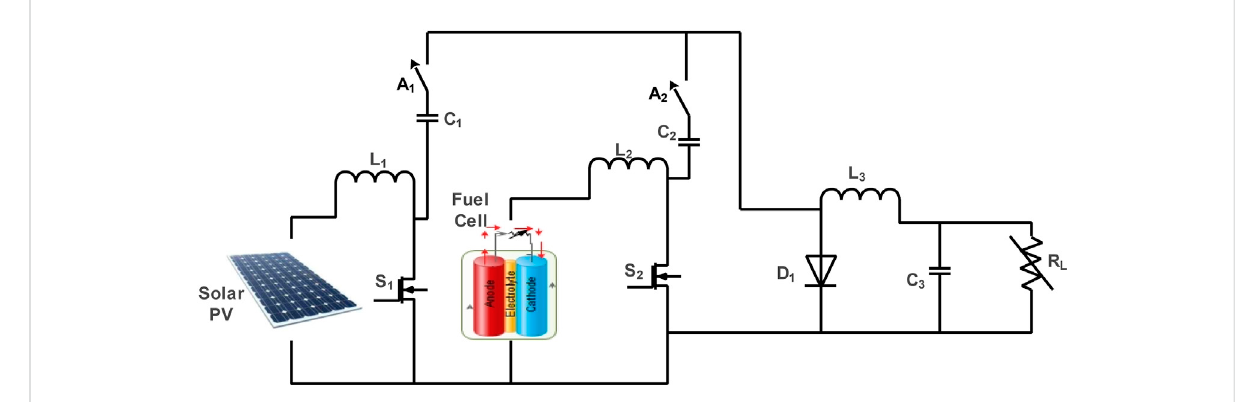
FIGURE 3 Proposed dual input single output non-isolated DC-DC